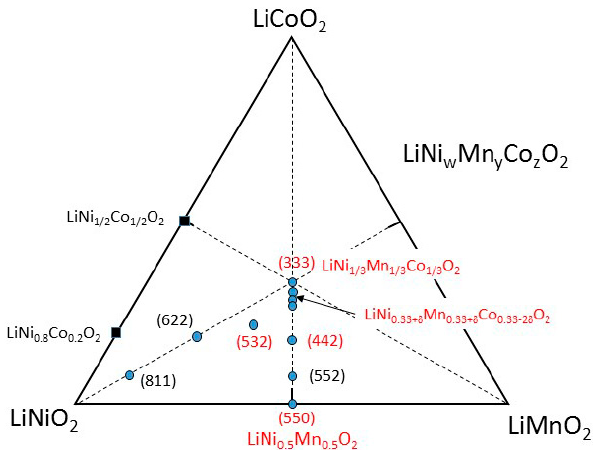
Figure 3. Ternary phase diagram of the mixed transition-metal oxides LiNi w Mn y Co z O 2 ( w + y + z = 1) formed by the LiCoO 2 -LiNiO 2 -LiMnO 2 solid solutions. The compounds studied in this work are marked in red. The samples are noted ( w'y'z' ) where w' = 10 w , y' = 10 y and z' = 10 z .